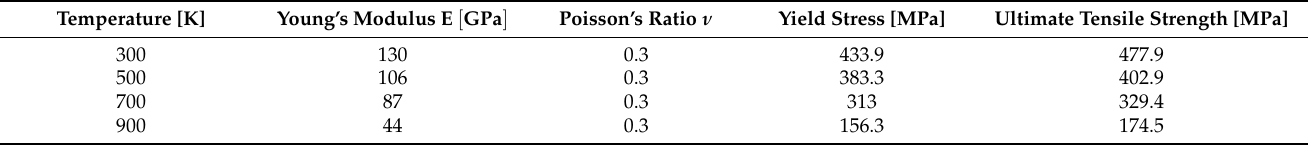
Table 3. Mechanical properties of CuCrZr